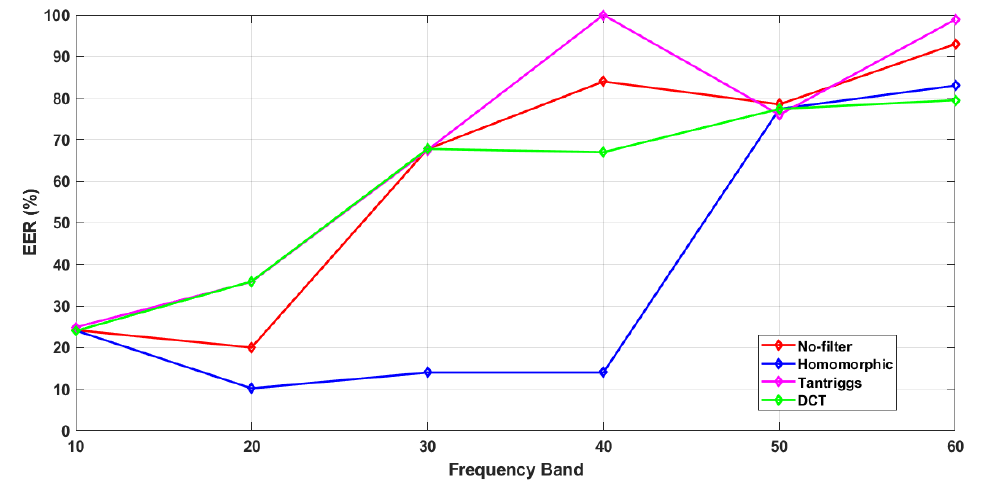
Figure 5. The effects of BLPOC FB variations on filtering operations in CSCD face